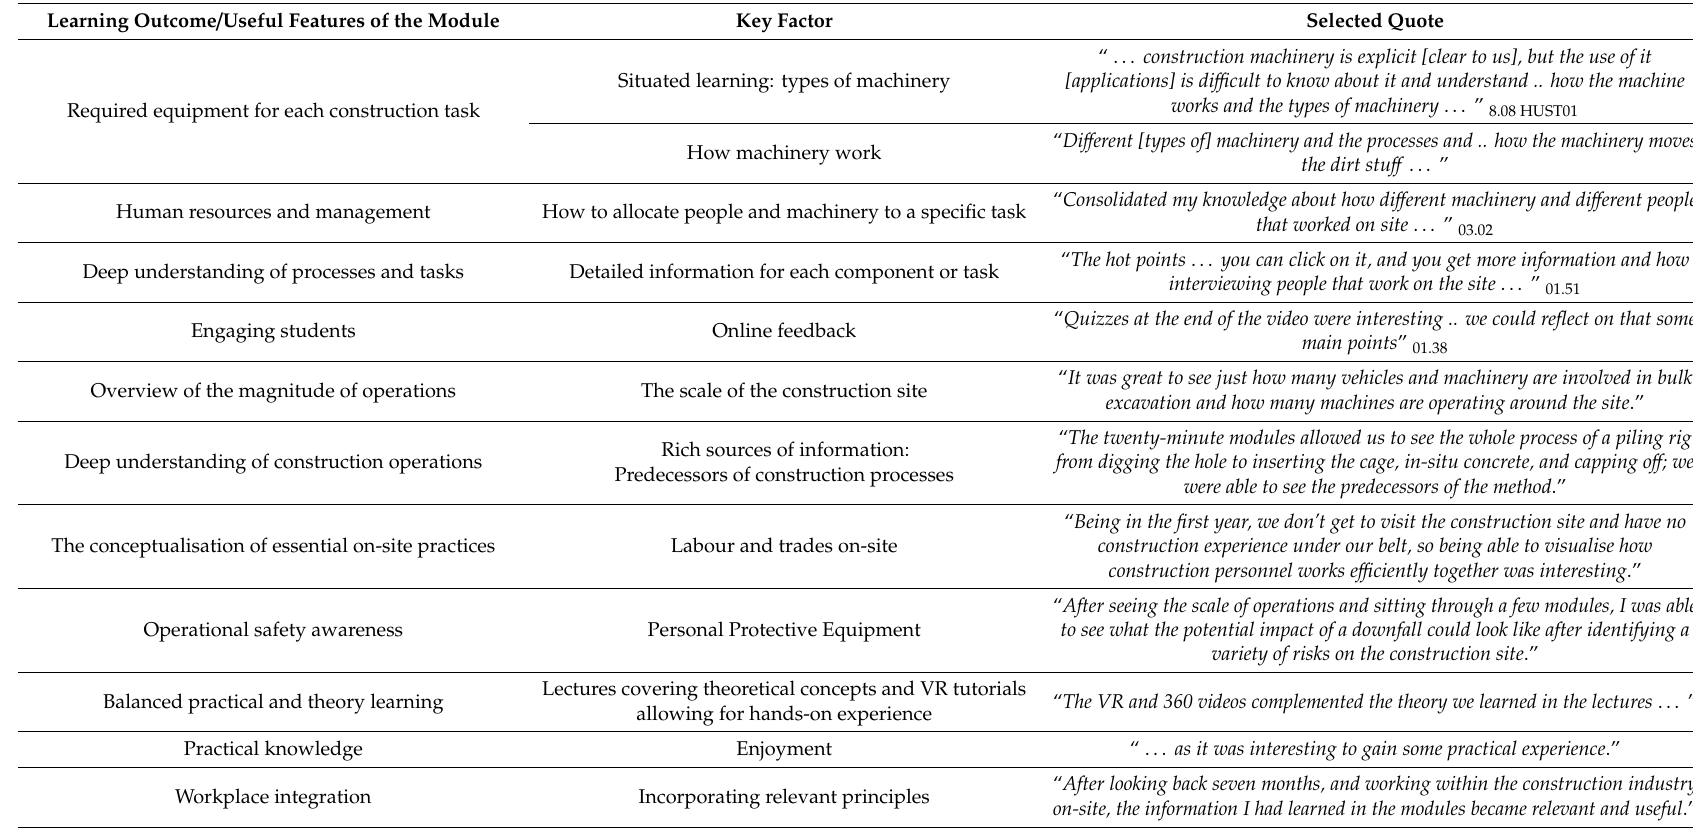
Table 7. Students’ reflection and critical factors of the VR application based on semi-structured